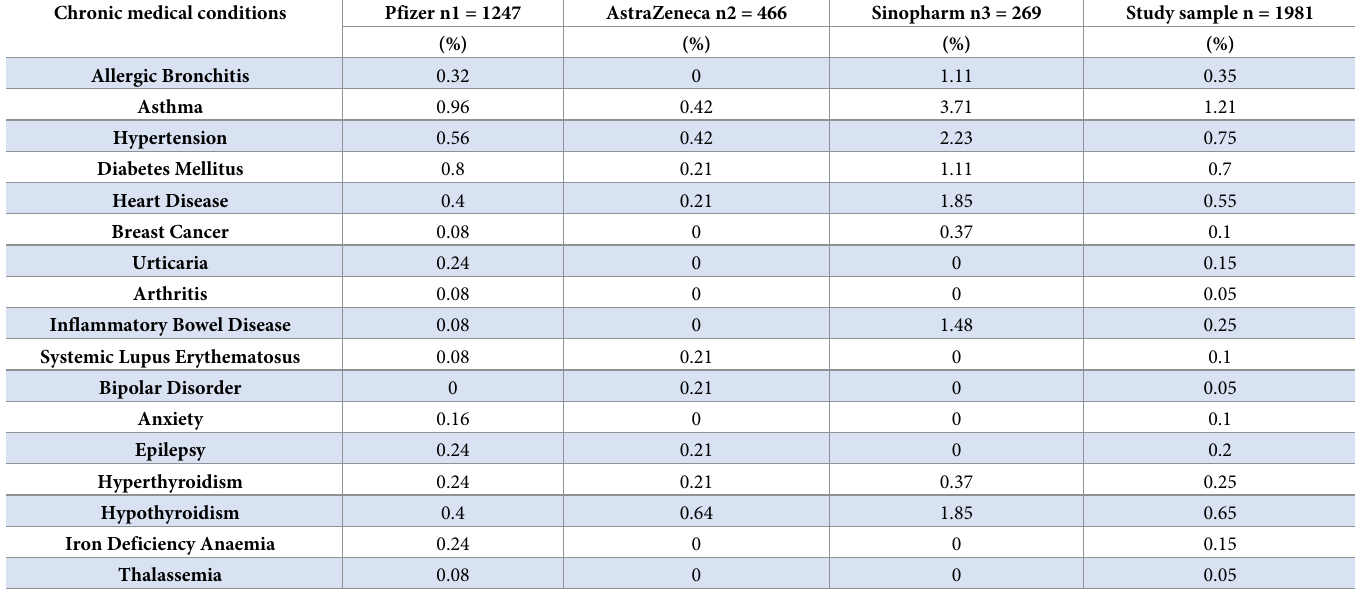
Table 1. Chronic medical conditions of vaccinated